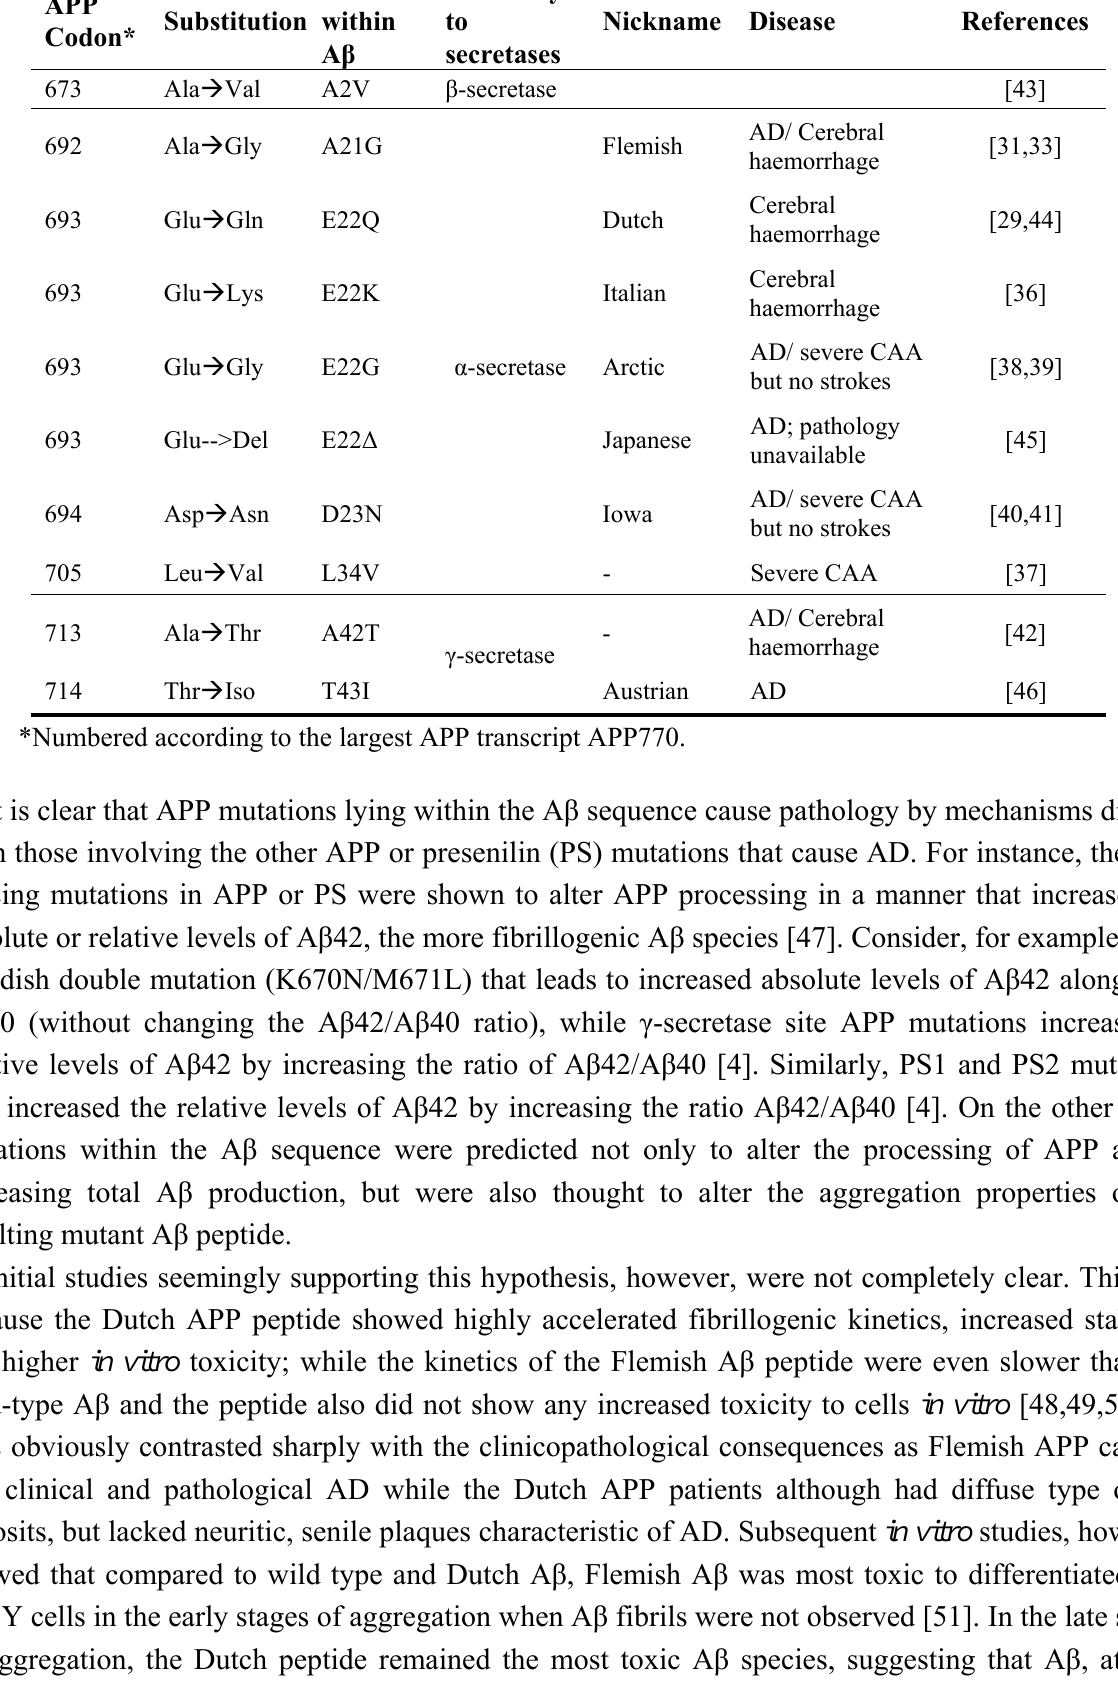
Table 2. Clinicopathological spectrum for APP mutations within A β 1-43 coding sequence.